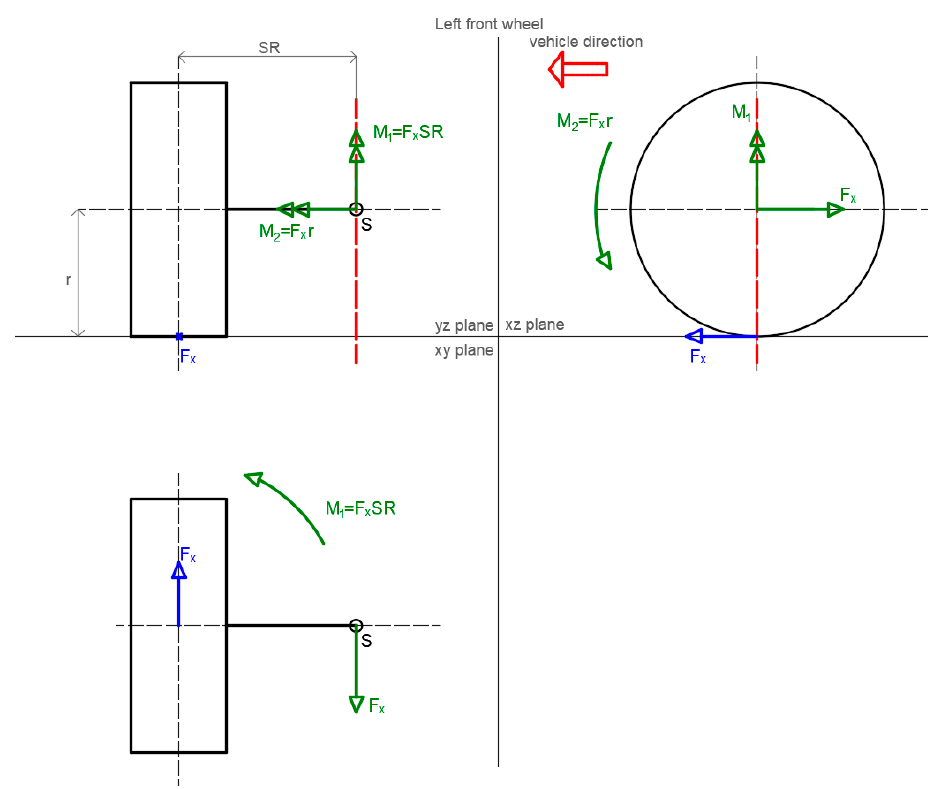
Figure 3. Simplified case 1: vertical steering axis.